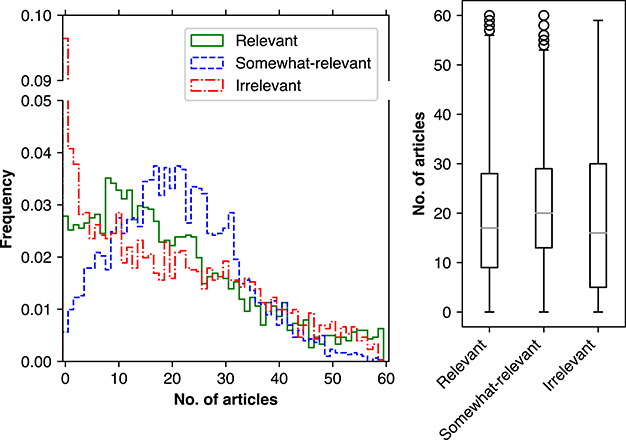
Left: frequency of seed articles (y-axis) containing \documentclass[12pt]{minimal}
\usepackage{amsmath}
\usepackage{wasysym}
\usepackage{amsfonts}
\usepackage{amssymb}
\usepackage{amsbsy}
\usepackage{upgreek}
\usepackage{mathrsfs}
\setlength{\oddsidemargin}{-69pt}
\begin{document}
}{}$n$\end{document} annotated candidate articles of respective labels (x-axis). Right: distribution of annotated candidate articles across all seed articles. Boxes represent the quartiles; middle lines are the median values.